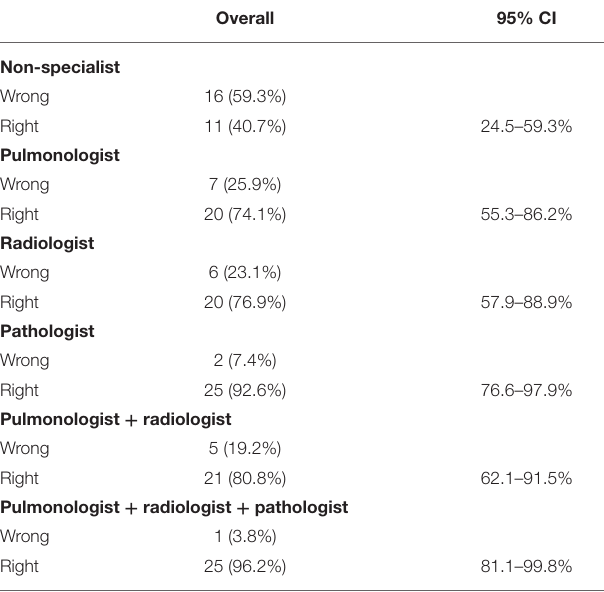
TABLE 5 | GEE model for estimating the relative correctness of specialists in respect to the non-specialist diagnosis. Estimate Standard error p